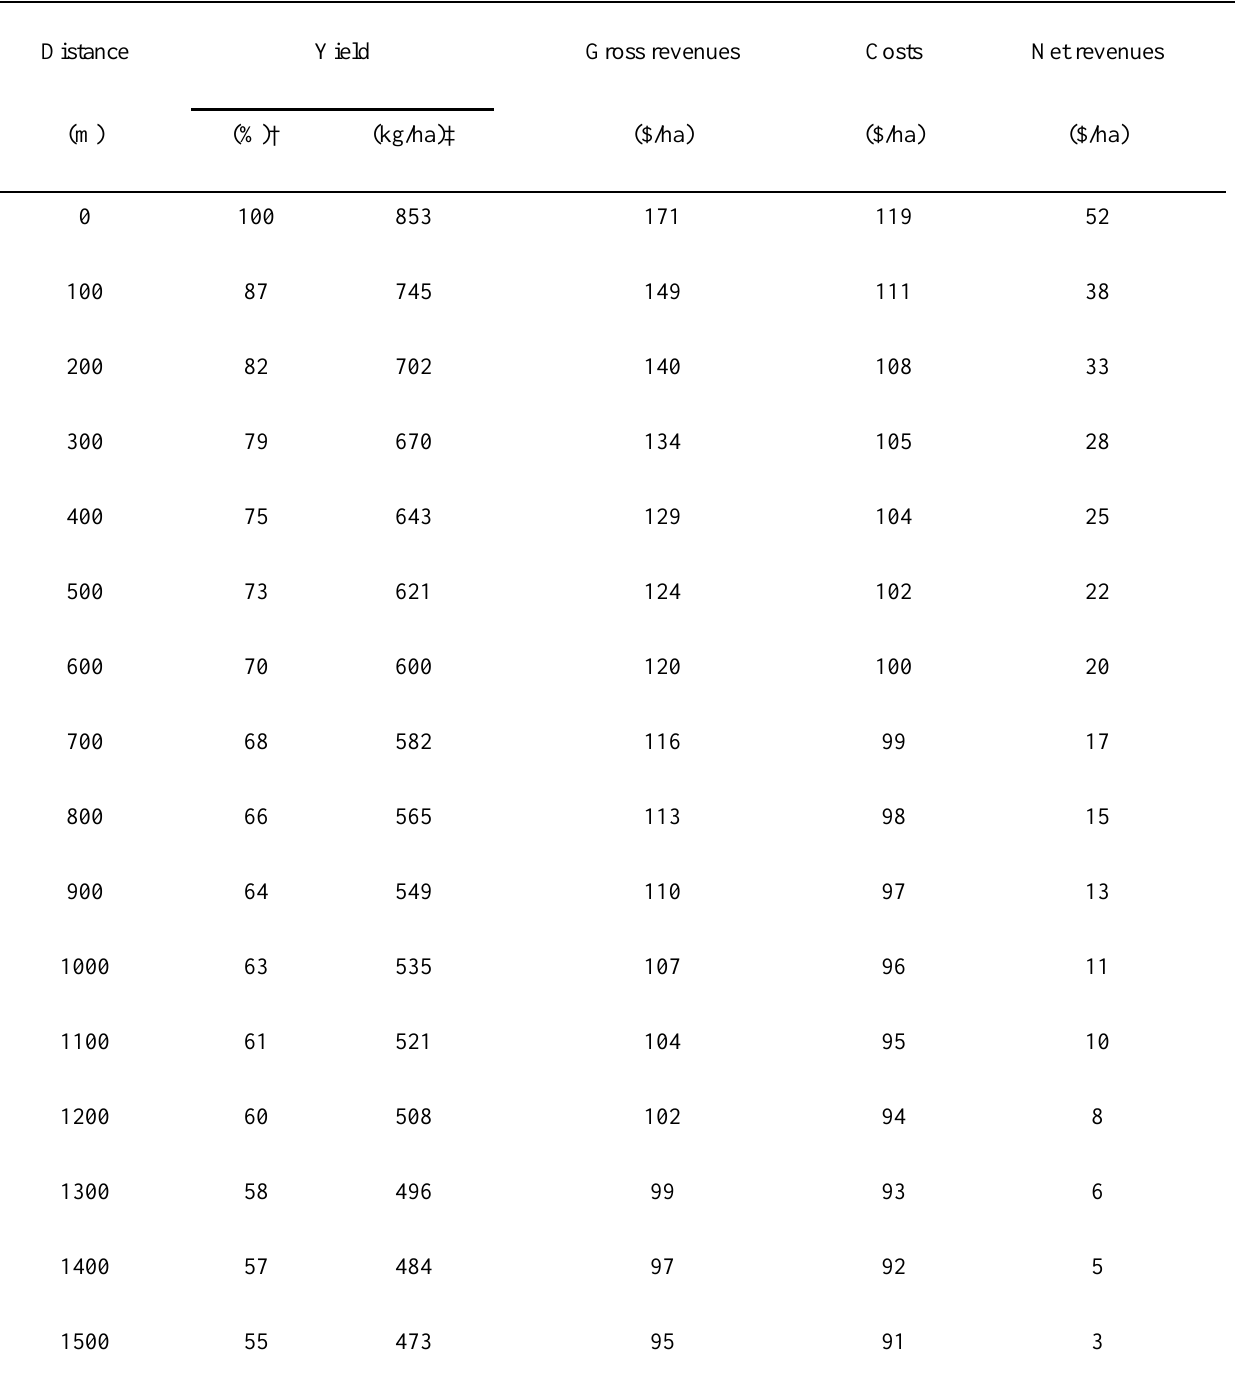
Table 2. Yield and net revenues of coffee systems in Ecuador depending on the distance to adjacent forest patches. All monetary values in